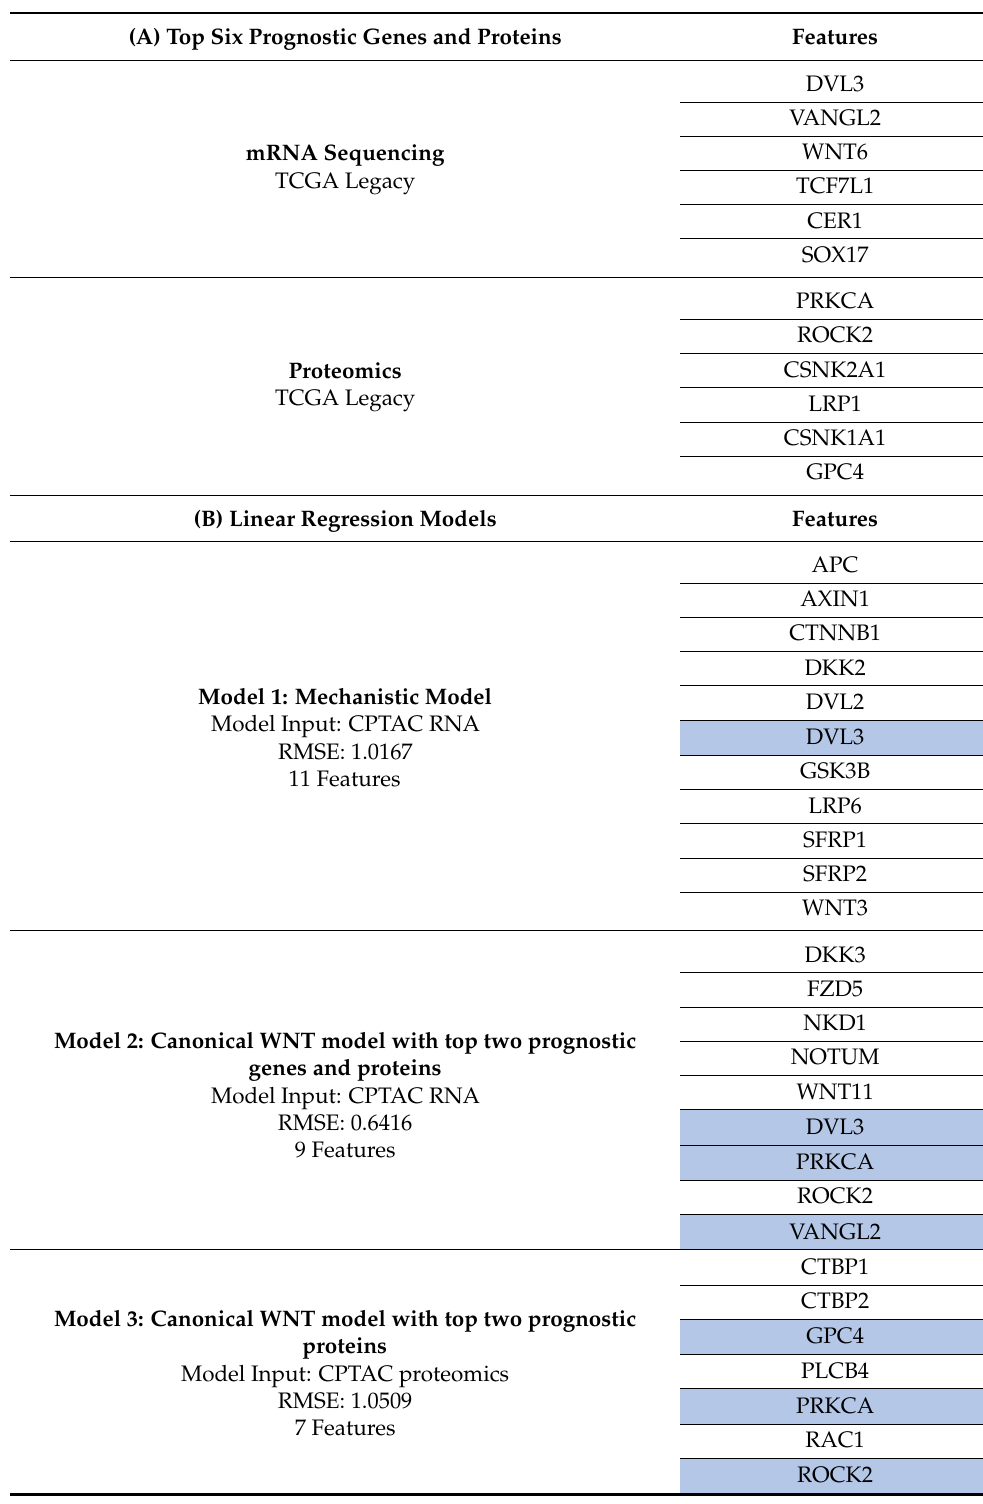
Table 6. Overview of the significant genes and proteins and the linear regression machine learning models. ( A ) List of the top six significant features from RNA sequencing and proteomics from TCGA Legacy datasets. ( B ) Model 1: An overview of the features used for the Mechanistic WNT pathway model. Models 2 and 3: An overview of the features used for the canonical WNT pathway, from CPTAC RNA and proteomics datasets, respectively. The number of features used and associated RMSE for each model is listed in the first column. “RMSE” = root mean squared error. Significant features are highlighted in